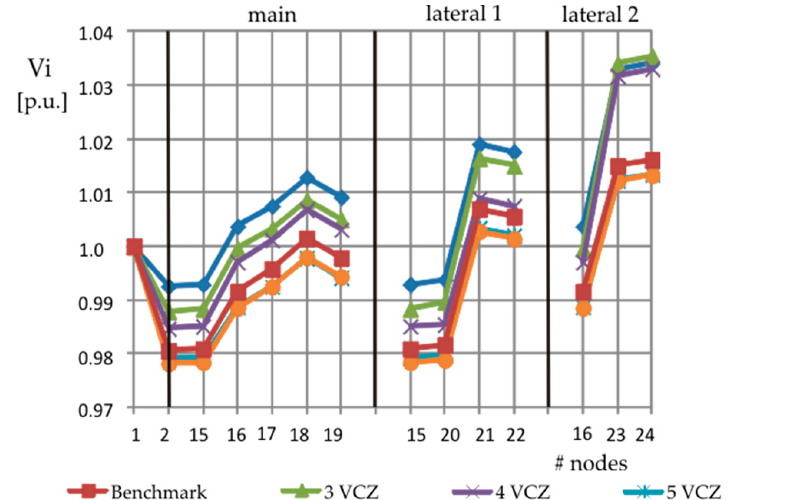
Figure 6. Voltage profiles for Case R —DG: P algorithm—feeder 2. Figure 6 : Voltage profiles for Case R — DG: P algorithm—feeder 2. Figure 6 : Voltage profiles for Case R — DG: P algorithm—feeder 2.